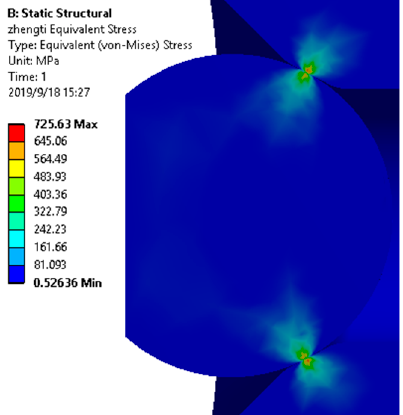
Figure 11. The simulation results of equivalent stress.